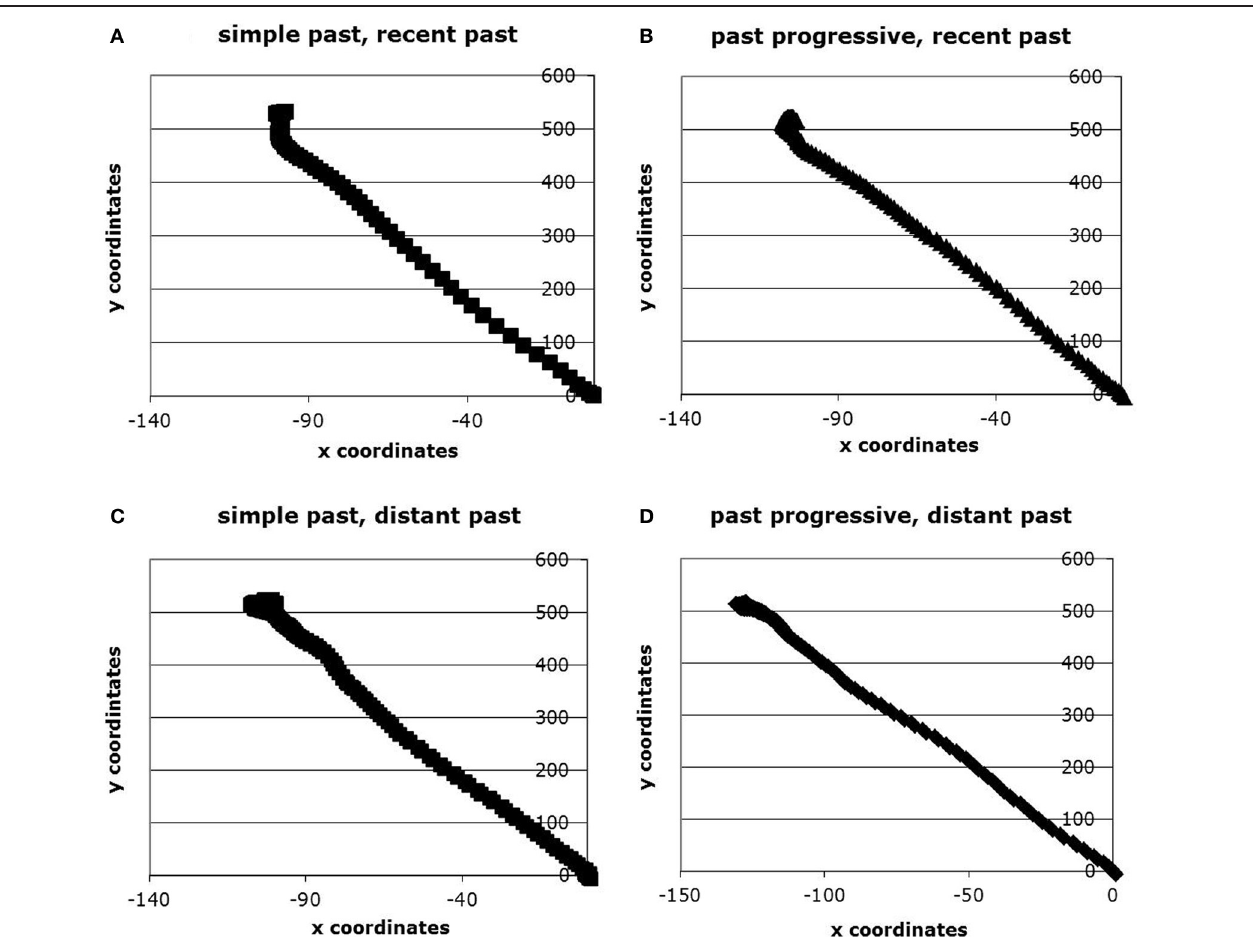
FIGURE 3 | Average time-normalized trajectories produced in response to simple past, recent past targets (A); past progressive, recent past targets (B); simple past, distant past targets (C); and past progressive (PP) distant past targets (D).